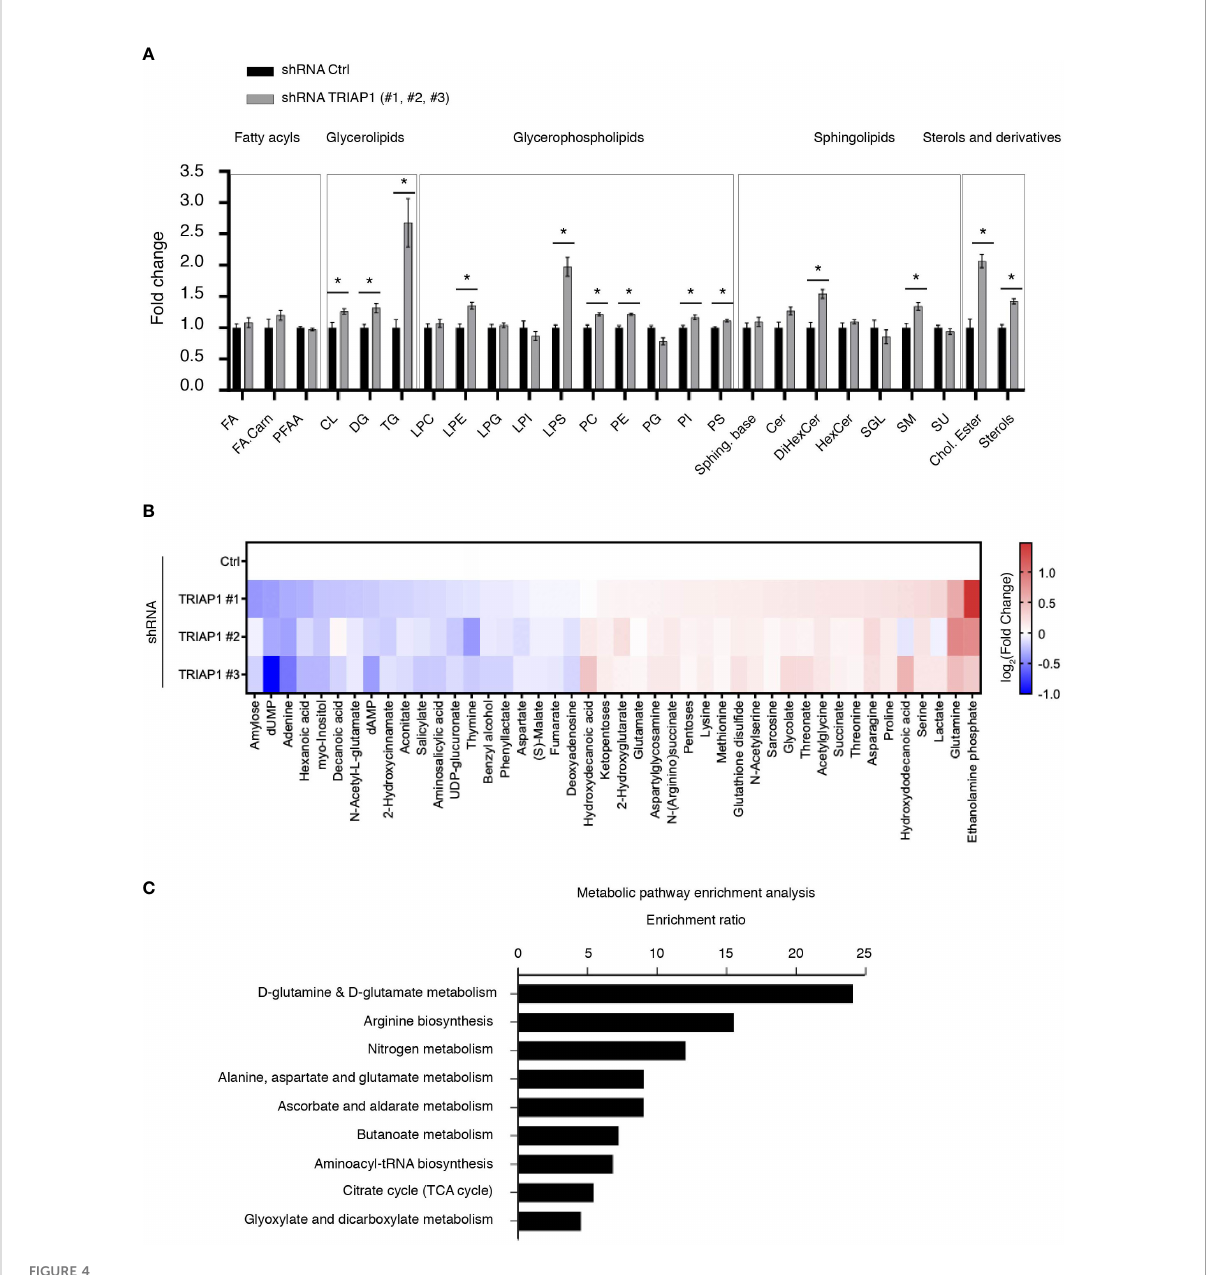
FIGURE 4 Impact of TRIAP1 depletion on cellular lipidome and metabolome. (A) Lipidomics analysis of HCT116 cells transduced with lentiviral control (Ctrl) or TRIAP1 (TRIAP1 #1, #2, #3) shRNAs. Relative abundance of indicated lipid classes is expressed as the fold change in combined TRIAP1 shRNA (#1, #2, and #3) treated cells relative to control cells. Data are represented as the mean ± SEM (Ctrl n=6 vs. TRIAP1 n = 18). Mann – Whitney tests are used for statistical comparisons *p<0.05. Cer, ceramides; Chol.Ester, cholesteryl esters; CL, cardiolipins; DG, diacylglycerols; DiHexCer, dihexosylceramides; FA, free fatty acids; FA.Carn, fatty acyl carnitines; HexCer, hexosylceramides; LPC, lyso-glycerophosphocholines; LPE, lyso- glycerophosphoethanolamine; LPG, lyso-glycerophosphoinositols; LPI, lyso-glycerophosphoinositols; LPS, lyso-glycerophosphoserines; PC, glycerophosphocholine; PE, glycerophosphoethanolamines; PFAA, primary amides; PG, glycerophosphoglycerols; PI, glycerophosphoinositols; PS, glycerophosphoserines; SGL, gangliosides; SM, sphingomyelins; Sphing. Base, sphingoid bases; TG, triacylglycerols; Su, sulfoglycosphingolipids; Sterol, sterols. (B) Untargeted metabolomic pro fi ling of HCT116 cells transduced with lentiviral control (Ctrl) and TRIAP1 (TRIAP1#1, #2, #3) shRNAs and grown in standard growth conditions. Heatmap showing signi fi cantly different intracellular metabolites (Adj p-value <0.1; univariate non-parametric Kruskal – Wallis test, Benjamini – Hochberg correction). Data are represented as – log 2 (Fold Change) related to control cells. (C) Metabolite Set Enrichment Analysis (MSEA) of the signi fi cantly altered metabolites (Adj p-value <0.1) in TRIAP1-depleted HCT116 cells was performed using MetaboAnalyst 5.0 and KEGG open database (53). Signi fi cantly enriched pathways (p-value <0.05) are